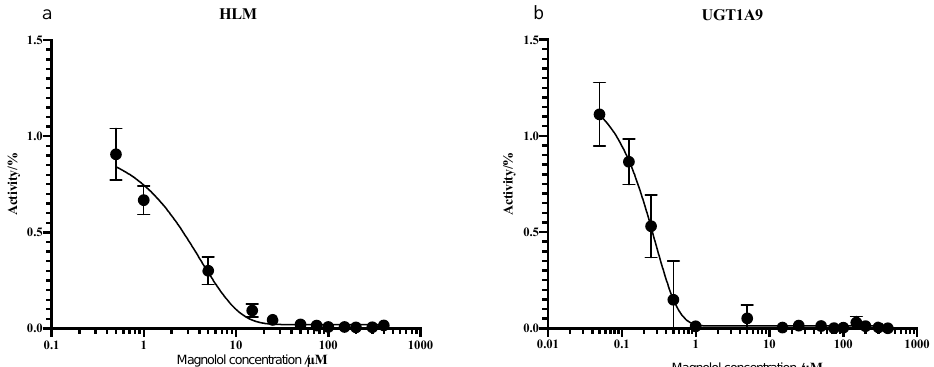
Figure 9. Inhibition of PTU glucuronidation in HLMs ( a ) and UGT1A9 ( b ) by magnolol. Each point represents the average of three replicates. Table 5. Inhibition of PTU glucuronidation in HLMs and recombinant UGT1A9 by magnolol.